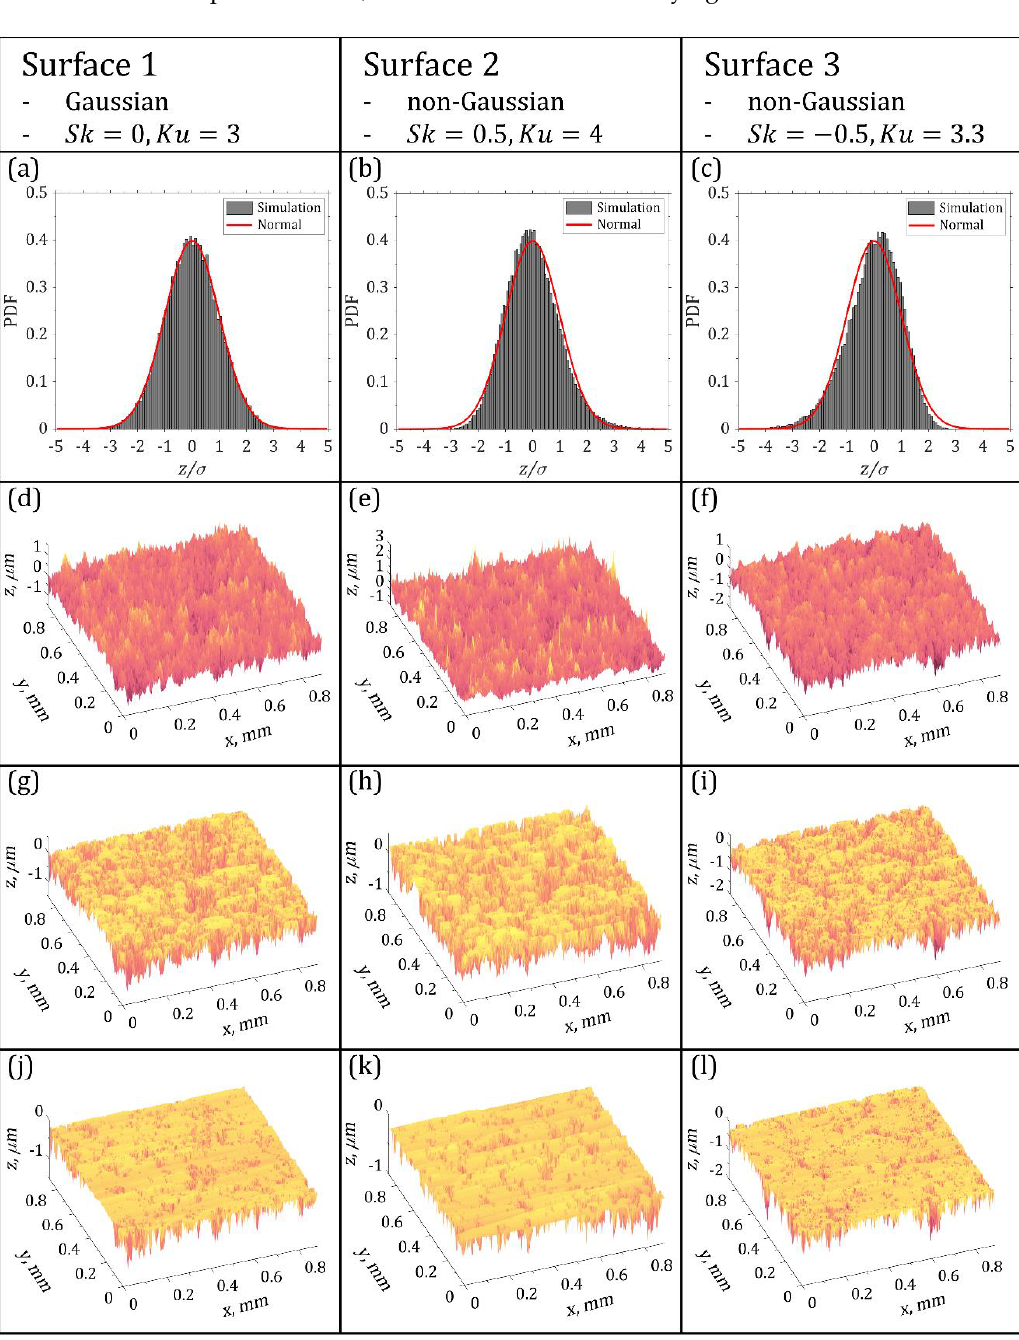
Figure 8. Gaussian and non-Gaussian surfaces for wear analysis: ( a ) – ( c ) Probability density func- tions of generated surfaces; ( d ) – ( f ) generated rough surfaces; ( g ) – ( i ) worn lower stationary surface; ( j ) – ( l ) worn upper moving surface. upper moving